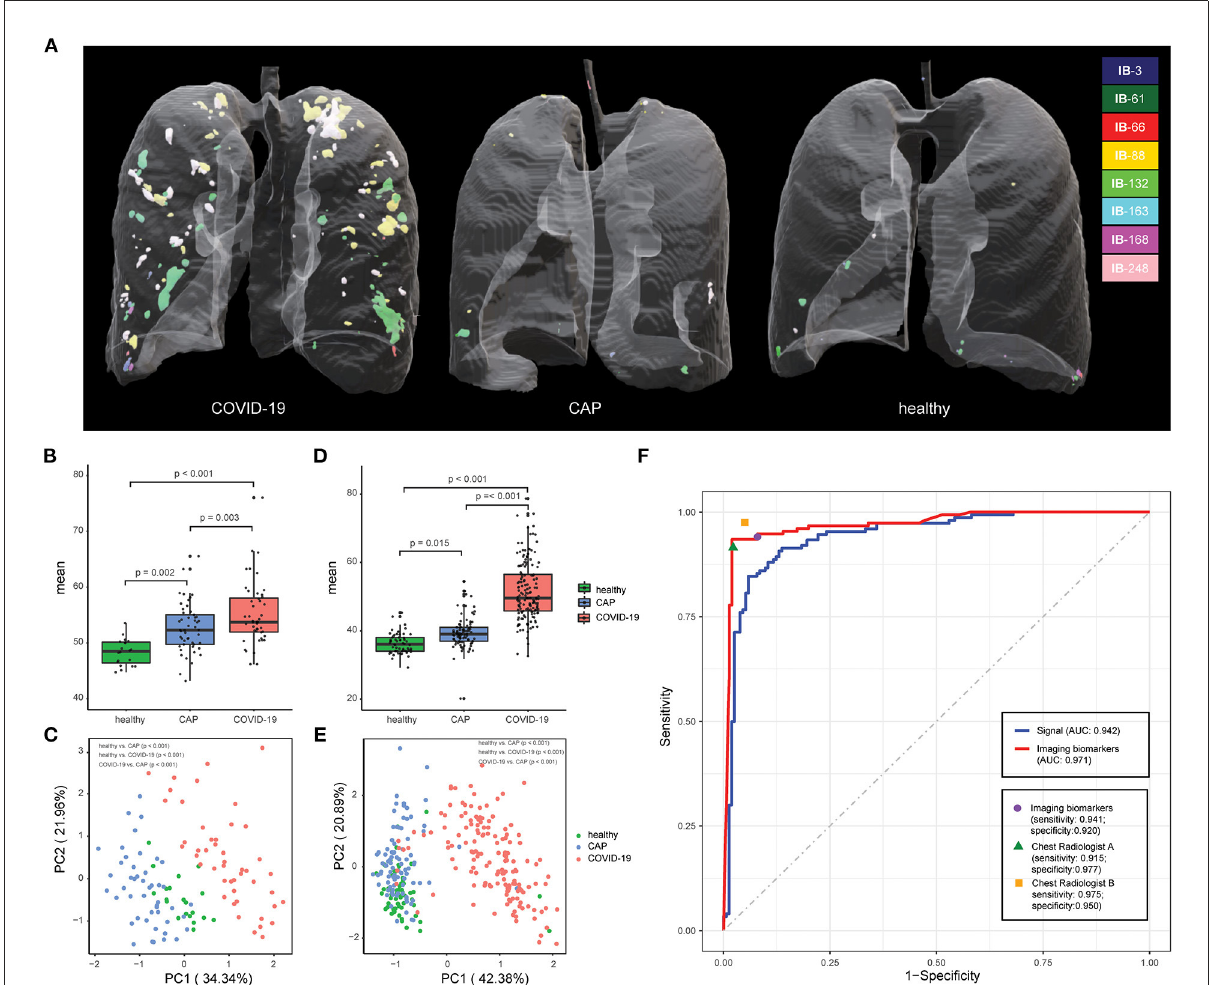
FIGURE3 Chest CT-based imaging biomarkers accurately predicts COVID-19. (A) Representative examples for 3D multispectral imaging biomarker visualization in COVID-19, CAP and healthy samples. (B) The boxplot shows differences in the vasculature-like signals among healthy, community acquired pneumonia (CAP), and COVID-19 patients in the training cohort. The p -values were obtained by the non-parametric Mann–Whitney test. (C) PCA of 8 imaging biomarkers in the training cohort. Twenty healthy participants (green dots), 49 CAP patients (blue dots), and 47 COVID-19 patients (red dots). The p -values were obtained from permutational multivariate analysis of variance (PERMANOVA). (D) The boxplot shows differences in the vasculature-like signals among healthy, community acquired pneumonia (CAP), and COVID-19 patients in the validation cohort. The p -values were obtained by the non-parametric Mann–Whitney test. (E) PCA of 8 imaging biomarkers in the validation cohort. Sixty healthy participants (green dots), 90 CAP patients (blue dots), and 153 COVID-19 patients (red dots). The p -values were obtained from permutational multivariate analysis of variance (PERMANOVA). (F) Screening performance of signal-based model, imaging biomarker-based model, and two COVID-19 experienced radiologist on validation